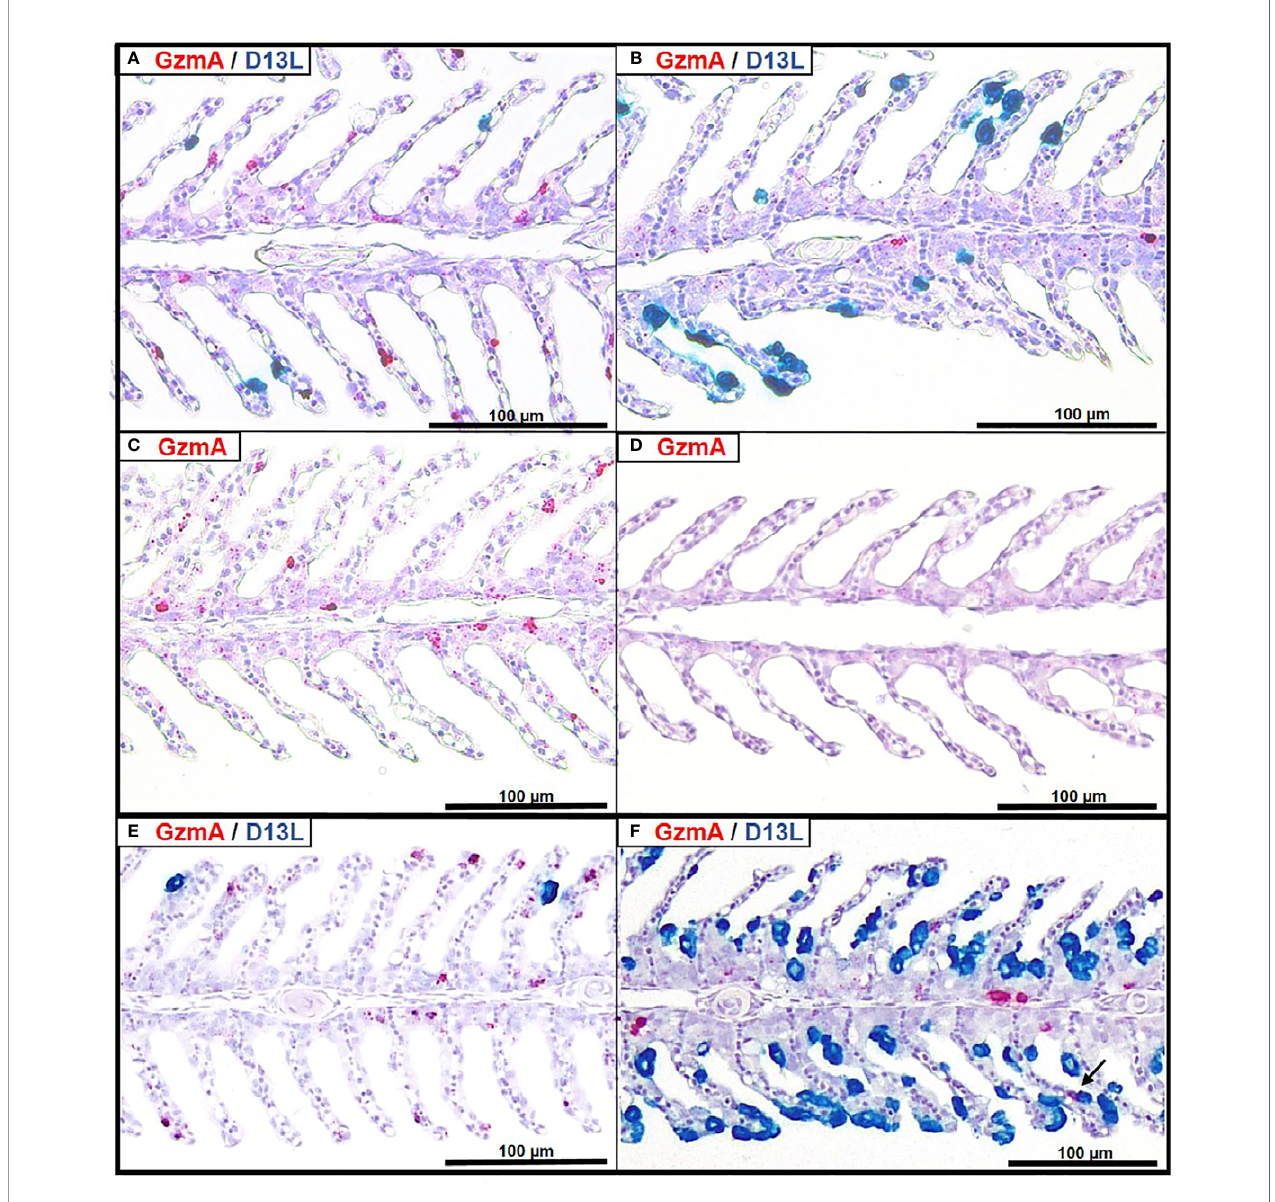
FIGURE 6 | Duplex in situ hybridization (RNAscope) demonstrating the distribution of SGPV (D13L, blue staining) and salmon GzmA (red staining) in gills from Atlantic salmon. (A) E.S group at 7 dpe. (B) E.H group at 7 dpe. (C) C.S group at 7 dpe. (D) C.H group at 7 dpe. (E) E.S group from 14 dpe. (F) E.H group at 14 dpe. Arrow show interaction between GzmA expressing cell and SGPV-infected